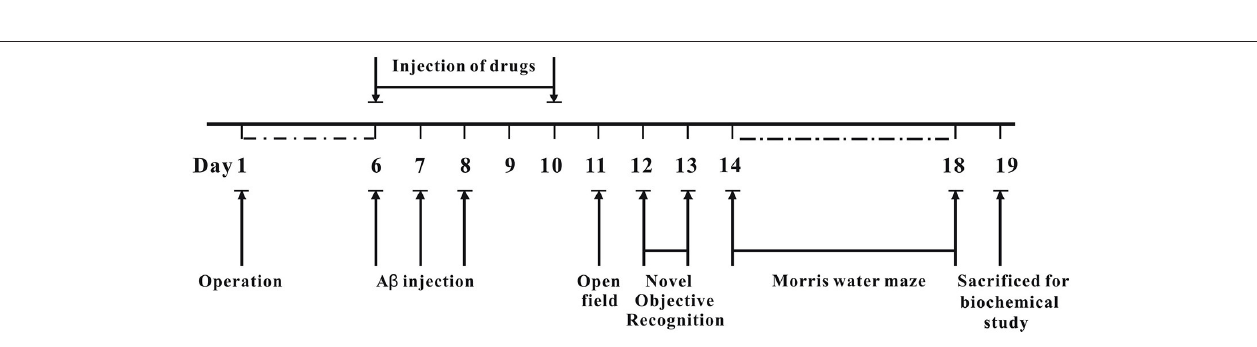
FIGURE 2 | Experimental design and schedule of animal